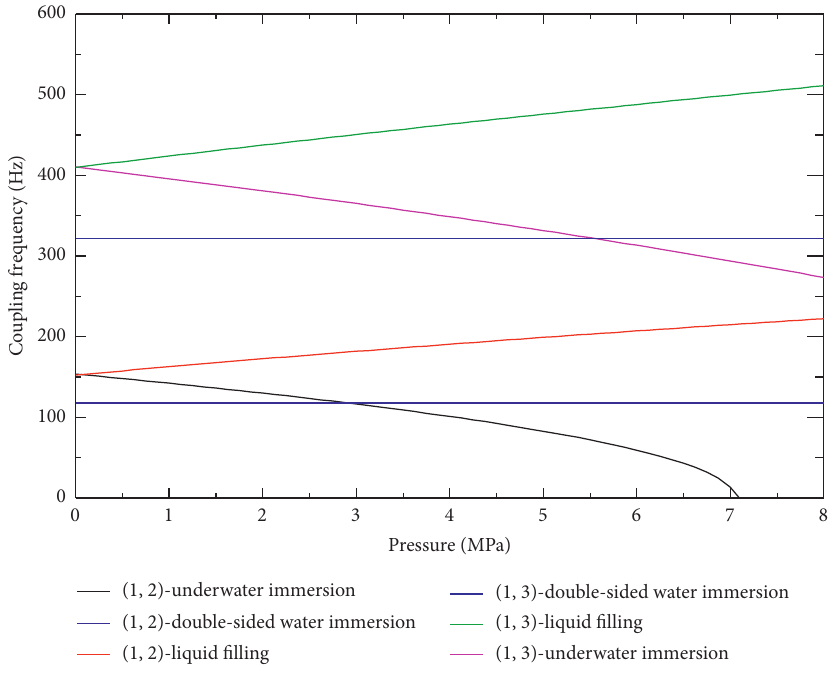
Figure 8: Coupling frequency curves of different hydrostatic pressure.